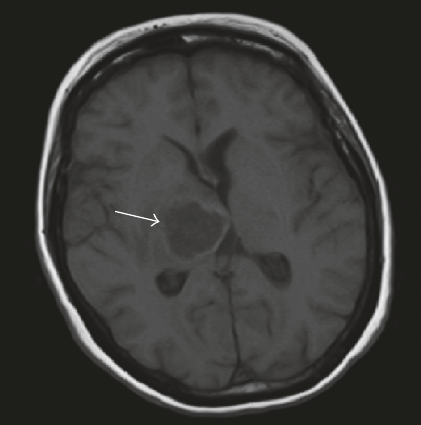
Figure 1: MRI brain with contrast showing intra-axial centered abscess (arrow) in the right thalamic region with associated right to left midline shift and downward herniation.